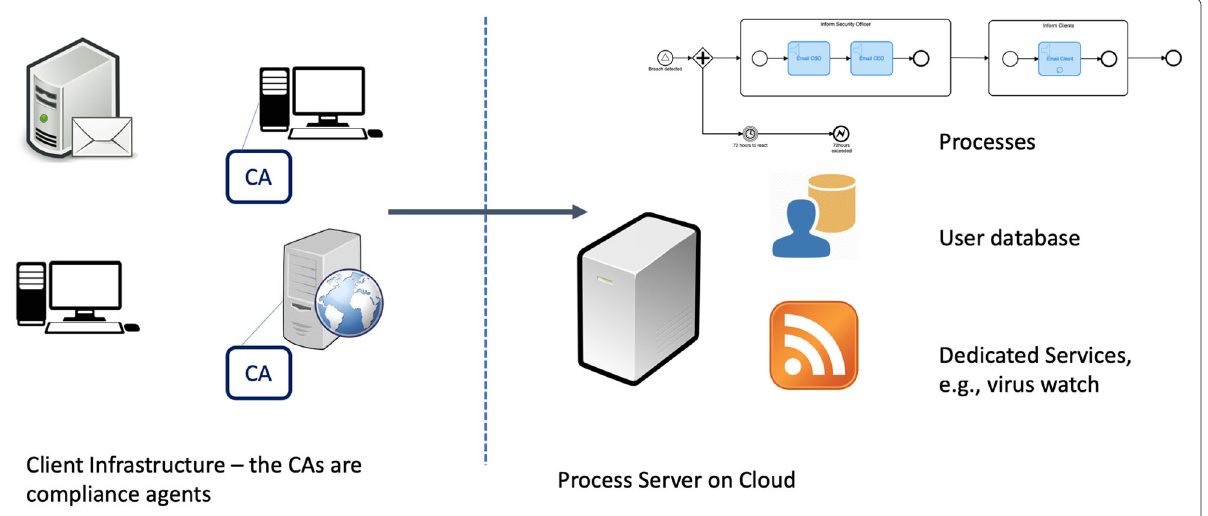
Fig. 4 Processes run on engine in a trusted environment